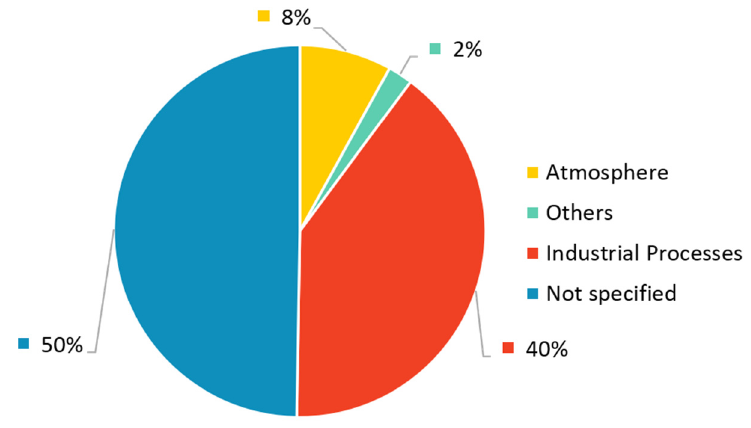
Figure 13. Most cited CO 2 sources in review papers.